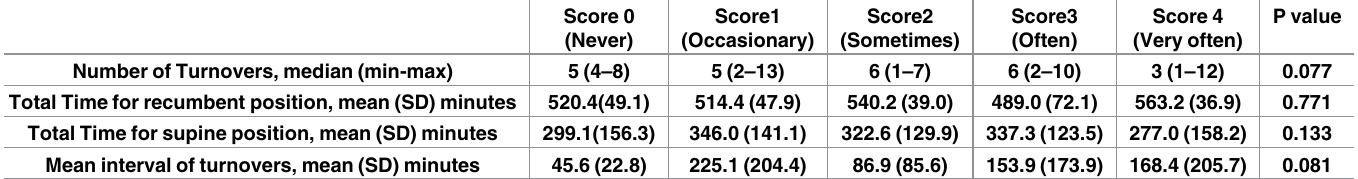
Table 3. Subjective awareness of difficulty turning in bed as evaluated by PDSS-2 item 9 and nocturnal kinetic parameters.